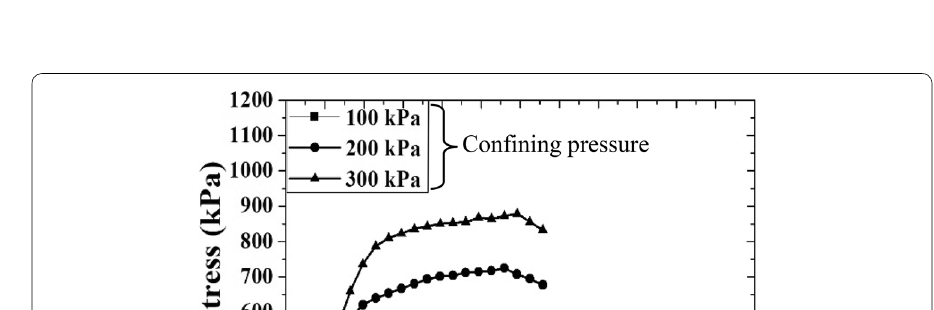
Figures 29, 30 and 31 represent the variation of deviatoric stress with axial strain for Borabanda MSW samples at different relative compaction (RC: 97%, 98% and 99%). The peak deviatoric stress value of sample at RC-97% under the confining pressure of 100 kPa, 200 kPa and 300 kPa was found to be 352.99 kPa, 463.15 kPa and 594.18 kPa respectively. In the case of RC-98% under the same confining pressure peak deviatoric stress value was observed to be 347.36 kPa, 805.56 kPa and 979.71 kPa while that at RC-99% peak deviatoric stress values are